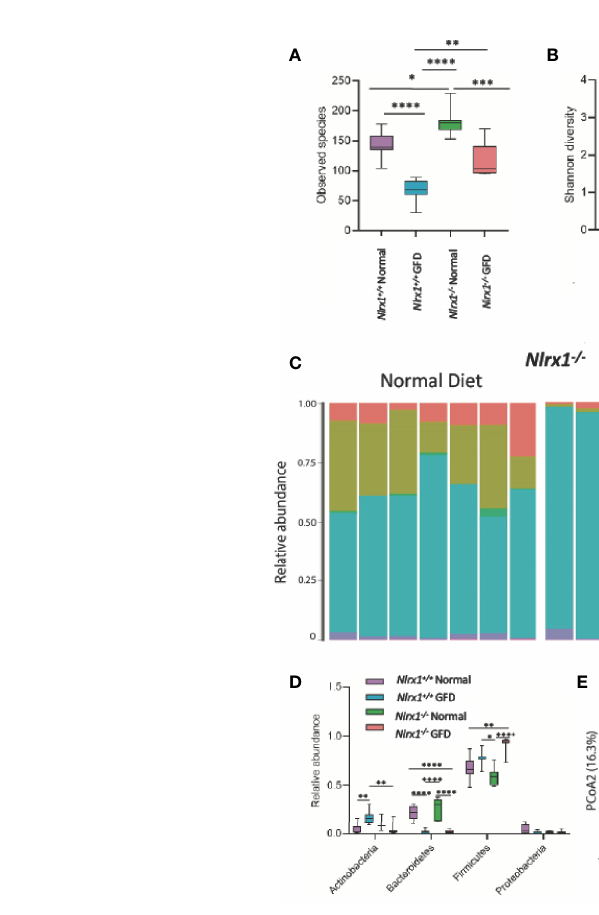
FIGURE 4 | NLRX1-de fi cient Mice Have Inherently Unique Micro fl ora Diversity. (A) NLRX1 -/- mice have signi fi cantly increased observed species of bacteria when fed a normal diet compared to GFD. (B) Assessment of Shannon Diversity depicts NLRX1 -/- mice to have signi fi cantly decreased diversity on a GFD compared to a normal diet. (C) The most abundant phyla present in the gut microbiota is Firmicutes. Bacteroidetes is the second most abundant phyla. Relative abundance is driven by diet, as these levels were signi fi cantly diminished in GFD mice. (D) There is signi fi cant variation in relative abundance of phyla present amongst the different treatment groups. (E) There is a clear clustering of the groups in PCoA analysis with clusters being apparent for both genetic status and diet type. GFD, n = 7 ; normal diet, n = 7, *p < 0.05, **p < 0.01, ***p < 0.001, ****p < 0.0001